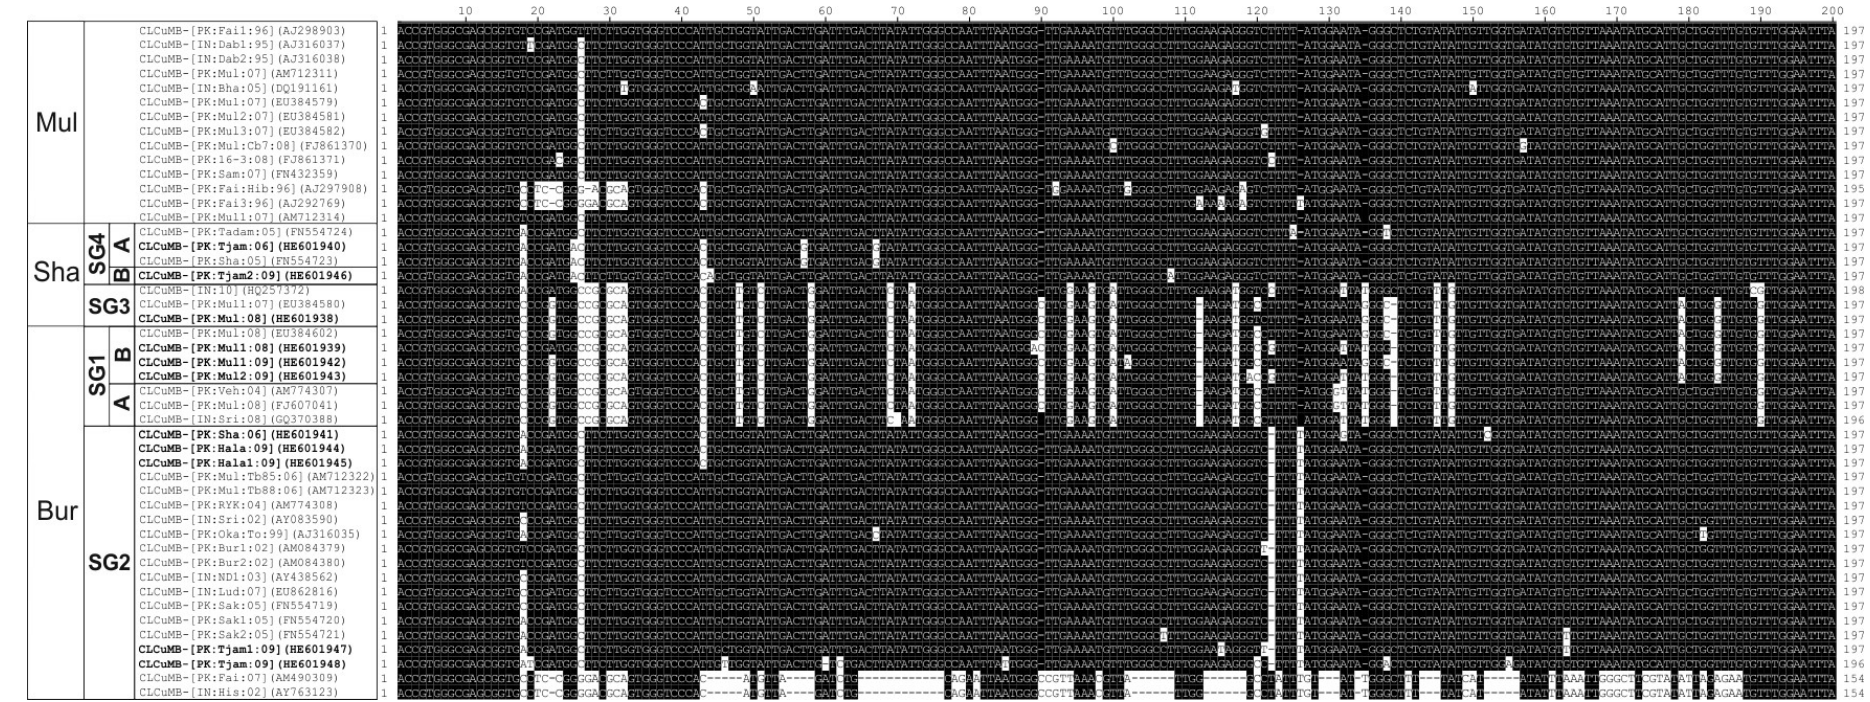
Figure 3. Alignment of the nucleotide sequences immediately downstream of the hairpin structure of CLCuMB isolates derived from the study presented here (highlighted with bold text) with selected sequences from the database. The sequence falls, at least in part, within the SCR. Gaps (-) were introduced into sequences to optimize the alignment. In each case, the isolate descriptor and accession number is given. Sequences differing from CLCuMB-[PK:Fai1:96] (AJ298903; a CLCuMB Mul isolate) are highlighted as black text on a white background. The strain of CLCuMB (Burewala [Bur], Multan [Mul] or Shahdadpur [Sha]) is shown on the left as well as the subgroups (SG) identified in Figure